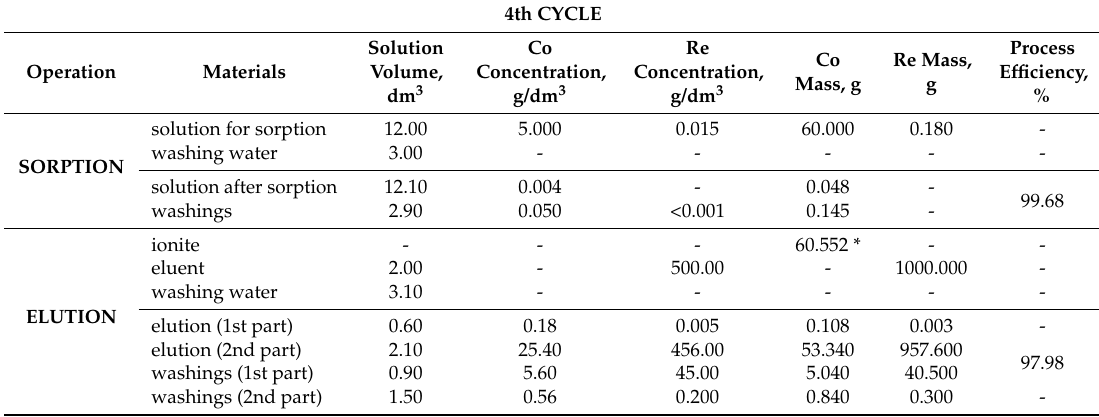
Table 11. Balance for cobalt(II) sorption and elution—4th cycle.